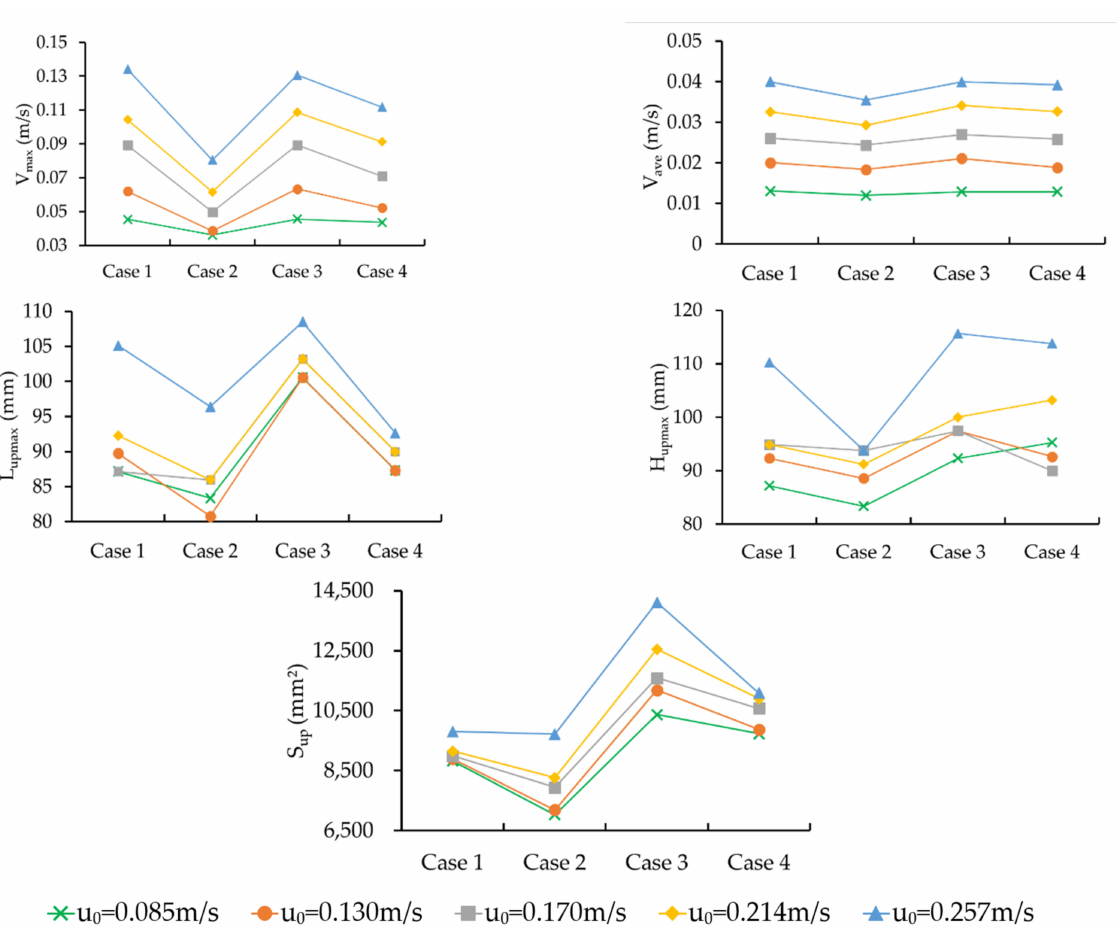
Figure 9. Upwelling values of M-shaped unit reefs under different testing conditions: V max , V ave , L upmax , H upmax , S up